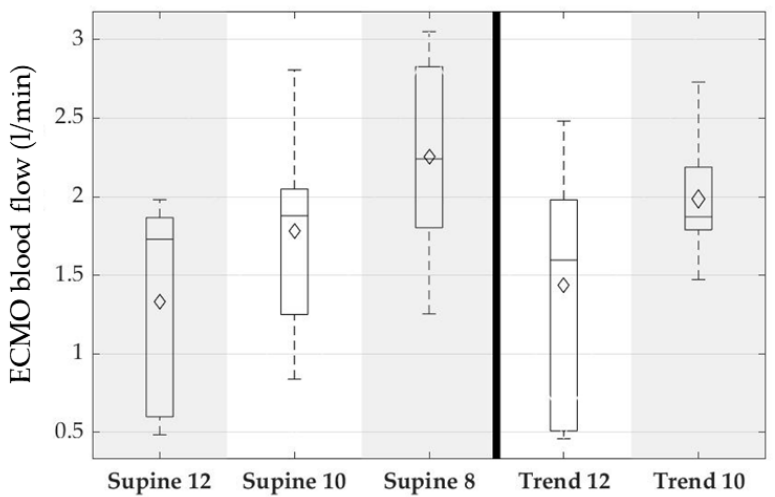
Figure 14 . ECMO blood flow for supine position and reverse Trendelenburg. Each column depicts one group of the experimental sequence. Supine: animal was positioned flat on the back; Trend: 45° reverse Trendelenburg position, simulating a mobilized patient; and 12,10,8: respiratory rate of the intermittent mechanical ventilation, simulating hypercapnic respiratory failure. Boxplots show 95%-CI (whiskers), 50%-interval (box), median (black bar), and mean (diamond).